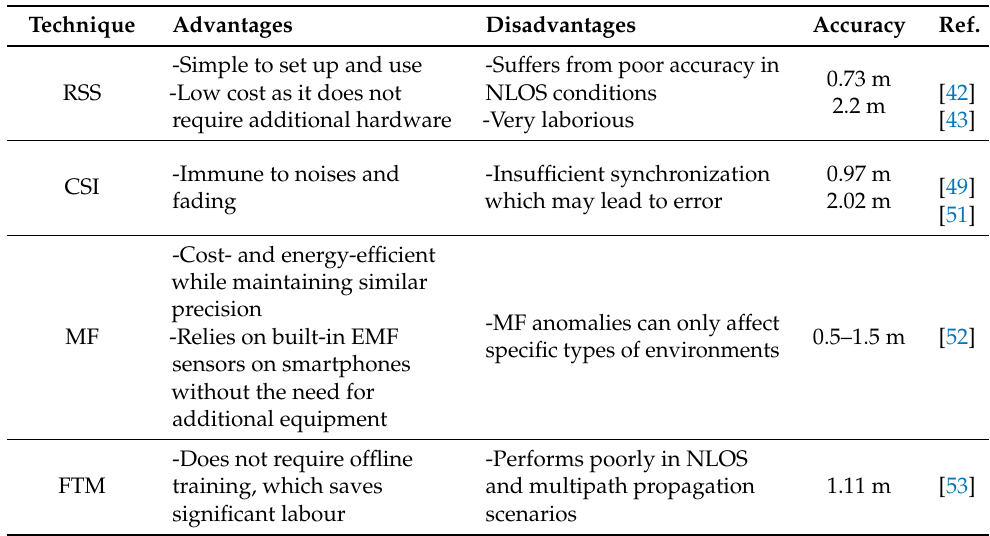
Table 3. Fingerprinting Approach 3D Positioning Existing